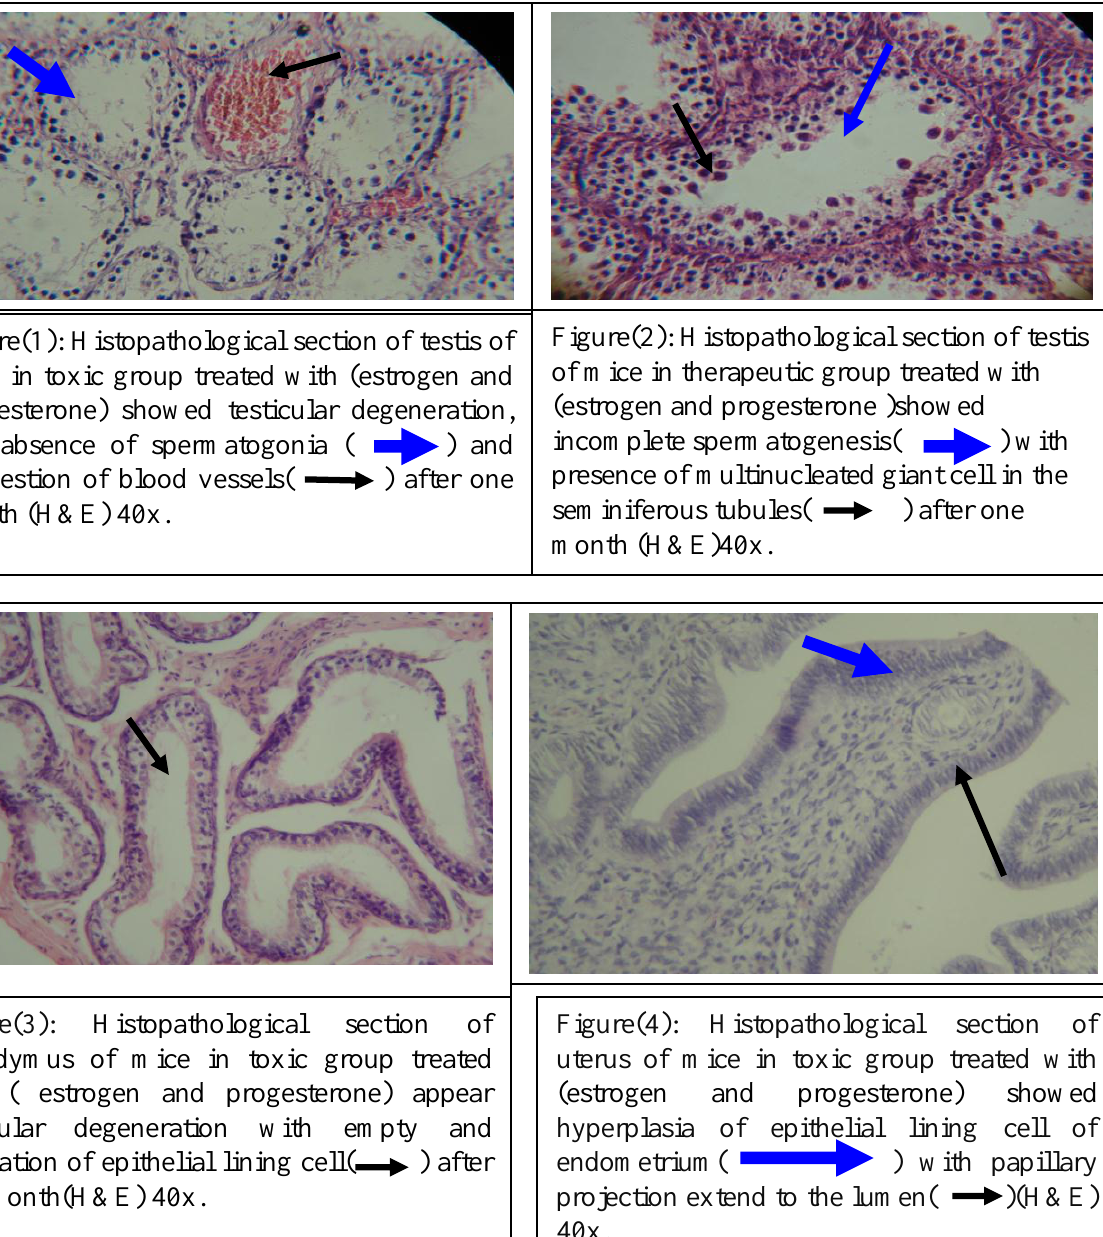
Figure(4): Histopathological section of uterus of mice in toxic group treated with (estrogen and progesterone) showed hyperplasia of epithelial lining cell of endometrium( ) with papillary projection extend to the lumen( )(H&E)